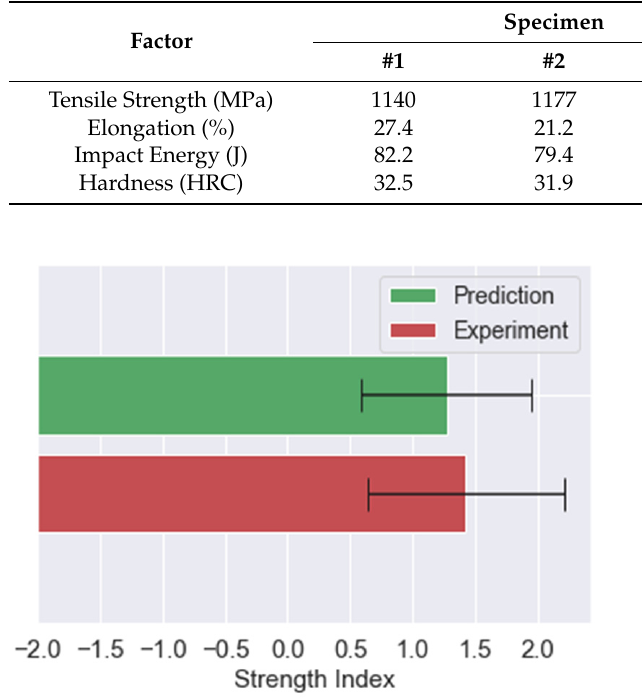
Table 7. Results of verification test for multiobjective optimization.